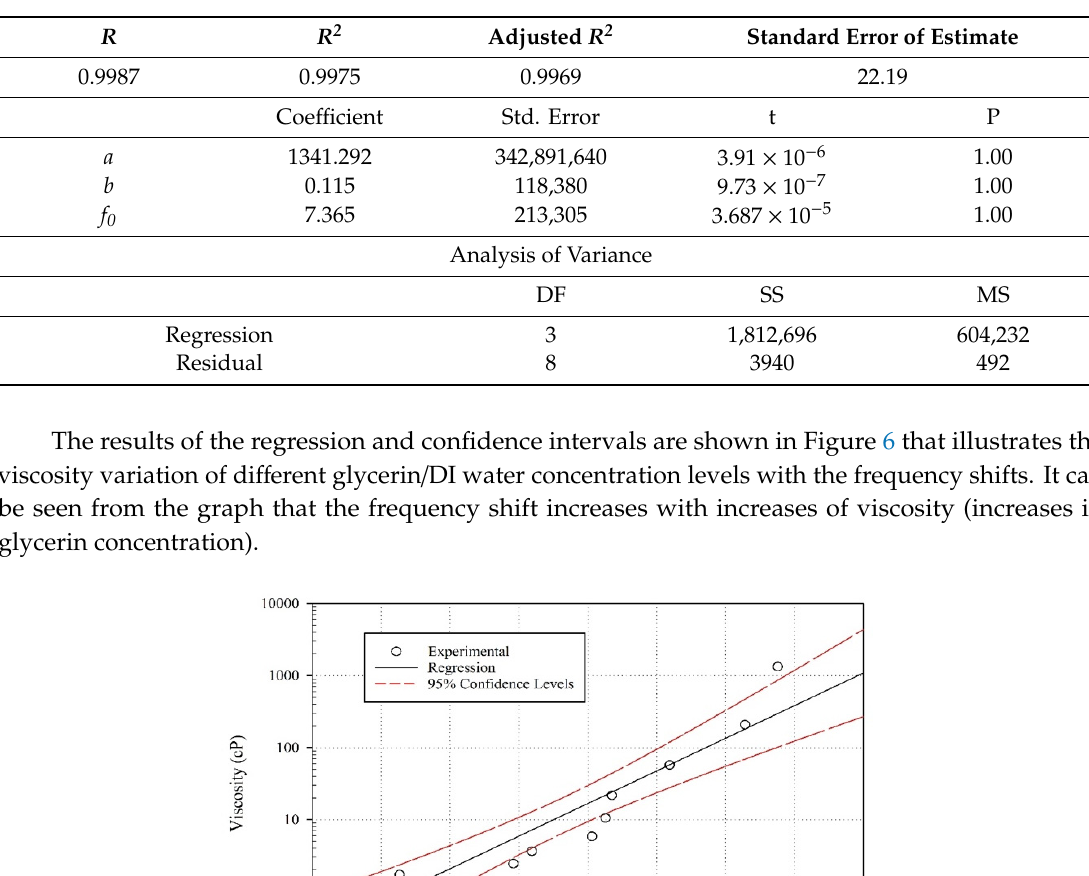
Table 3. Statistical analysis of the regression.